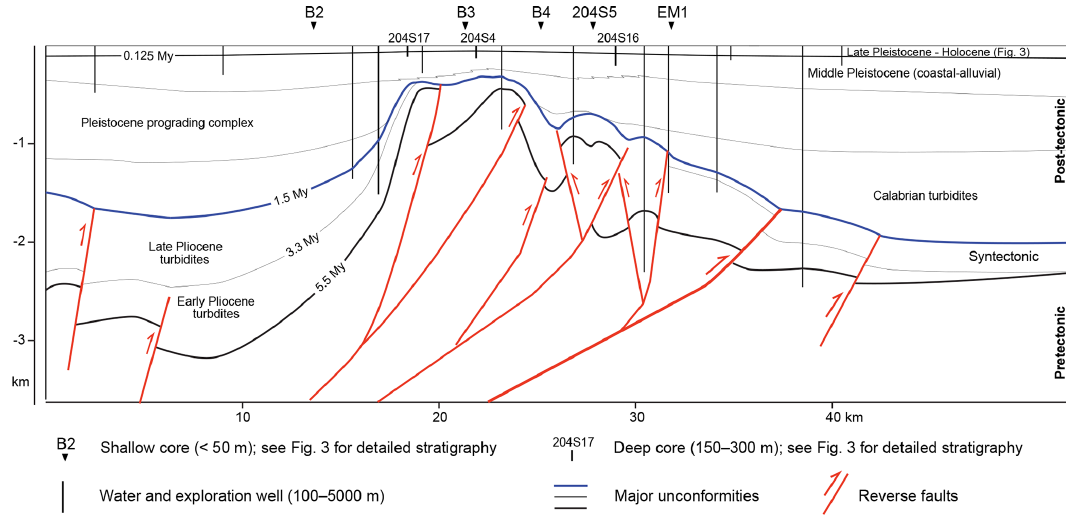
Figure 2. Interpreted seismic profile (see Fig. 1 for location) perpendicular to the main buried tectonic